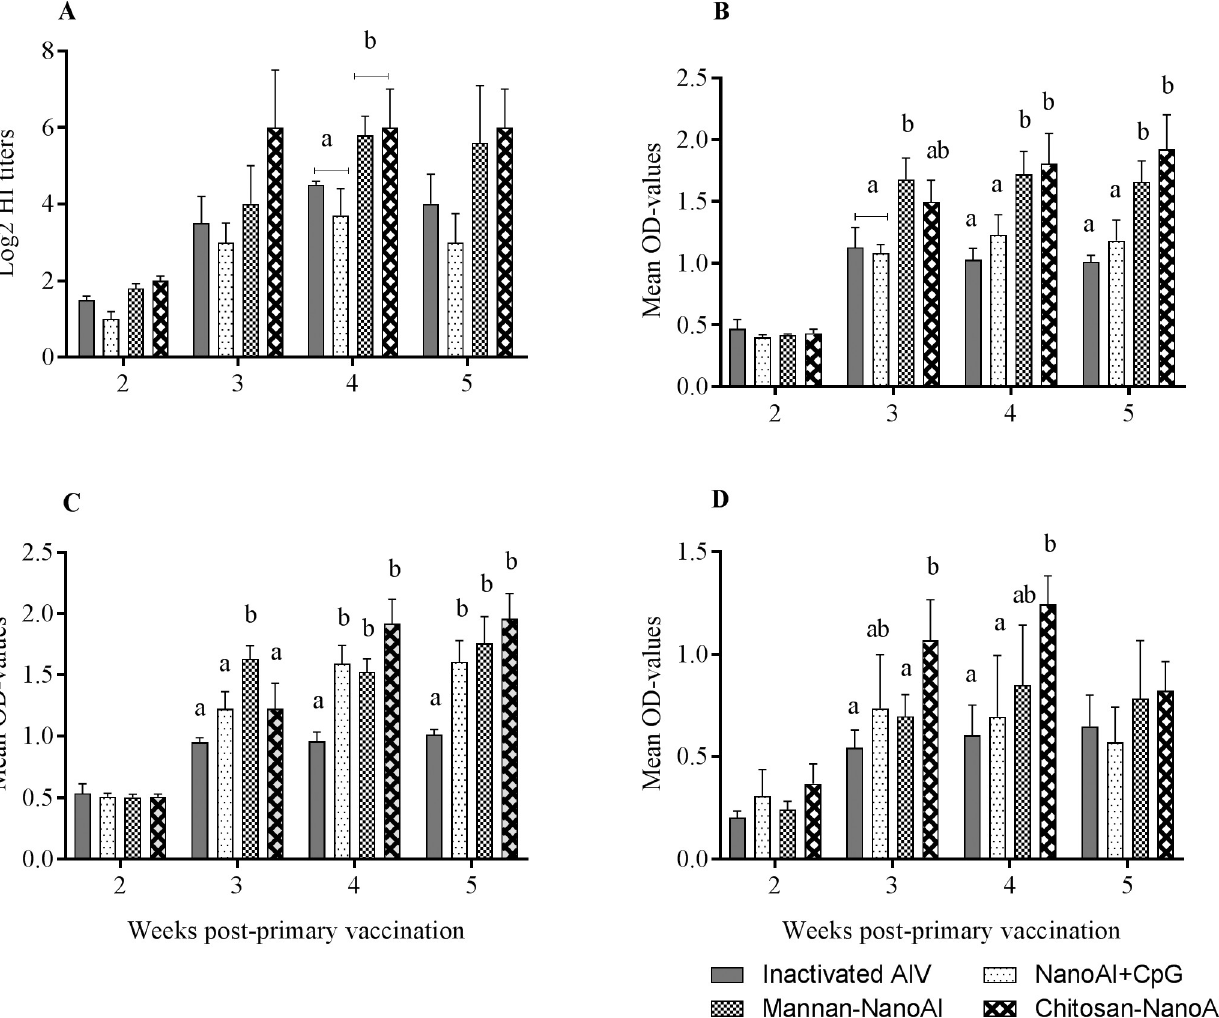
Fig 4. Serum HI titers (A) and serum IgG (B), and lachrymal IgG (C) and IgA (D) induced by surface modified PLGA NPs formulated AIV vaccines after nasal and ocular applications. One-week-old SPF chickens were vaccinated mucosally with nanoparticle formulated AIV vaccines or with whole-virus inactivated vaccine. Serum samples and lachrymal secretions were collected weekly for antibody determination. Data shown were mean ± SEM (n = 8/ group). P < 0.05 was considered significant. Different letters within a defined single time point show significant differences between groups, while identical letters within a defined single time point show no statistically significant differences between